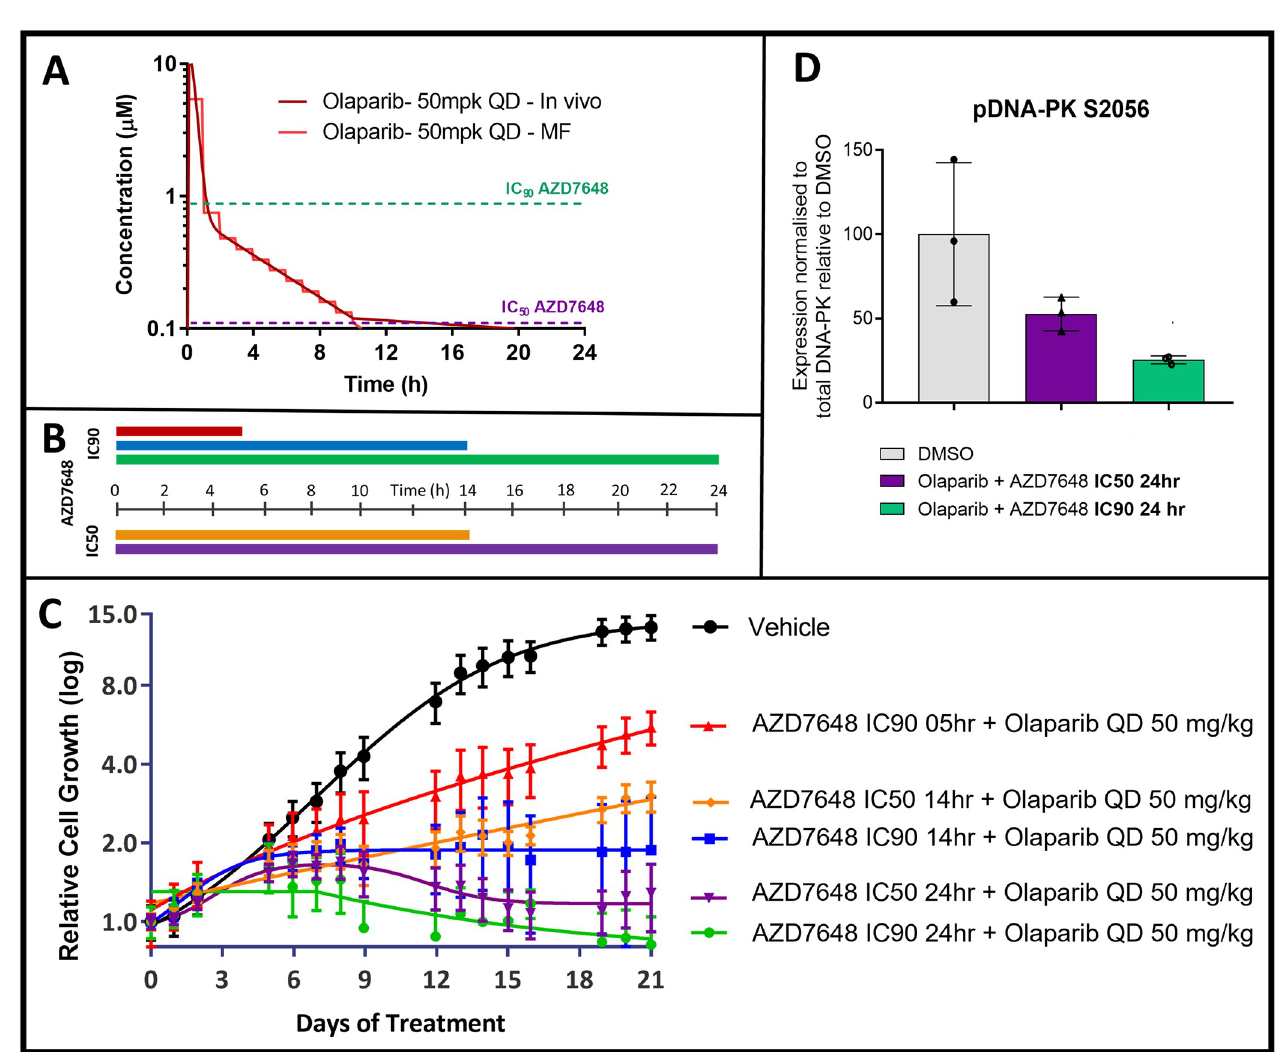
Fig 5. Investigating AZD7648 exposure parameters to maximise olaparib combination efficacy. (A) In vivo and Microformulator-replicated PK profile of olaparib (50 mg/kg QD) and fixed IC 90 and IC 50 concentrations for DNA-PK AZD7648. (B) Durations of daily exposure to AZD7648 at either IC 90 or IC 50 , (colours matched to C). (C) Growth inhibitory response, determined from Incucyte analysis, of FaDu ATM KO cells to olaparib and AZD7648 treatment delivered by the Microformulator at fixed IC 90 and IC 50 concentrations for indicated durations throughout each 24-hour cycle over 3 weeks. Data represent mean ± SEM of 3 technical replicates. (D) FaDu ATM KO cells were treated for 24 hours with olaparib plus AZD7648 at either IC 50 or IC 90 and whole cell lysates were collected. Proteins were separated by SDS-PAGE and detected by western blotting. The band intensity of pDNA-PK S2056 was quantified and expression was normalised to the quantity of the respective total protein. Graphs represent mean expression ± SD for pDNA-PK relative to its expression in the DMSO control. Individual data points represent technical replicates. Underlying data can be found in S3 Data. DNA-PK, DNA-dependent protein kinase; KO, knockout; PK,